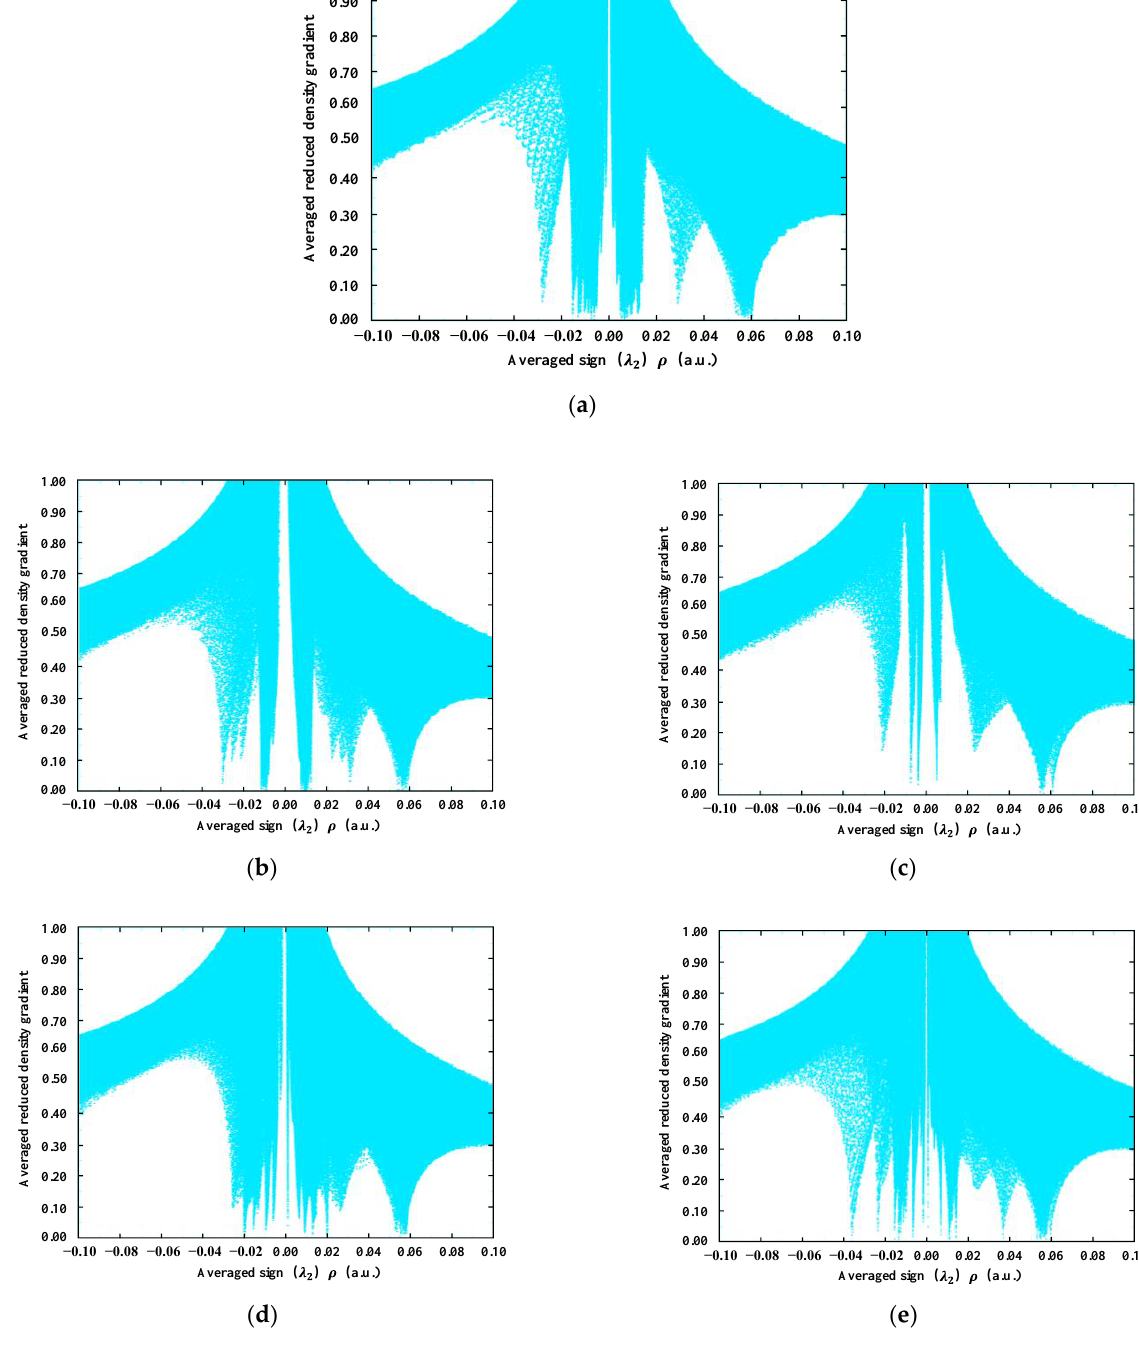
Figure 7. Diagrams of aRDG vs. averaged sign ( λ 2 ) ρ for three asphaltene molecules. RDG isosurfaces colored according to an RGB scheme over the range of 0.1 < sign ( λ 2 ) ρ < 0.1 a.u. ( a ) AsphalteneO, ( b ) AsphalteneT offset stacking, ( c ) AsphalteneT T-shaped stacking, ( d ) AsphalteneY offset stacking, and ( e ) AsphalteneY crossed stacking.